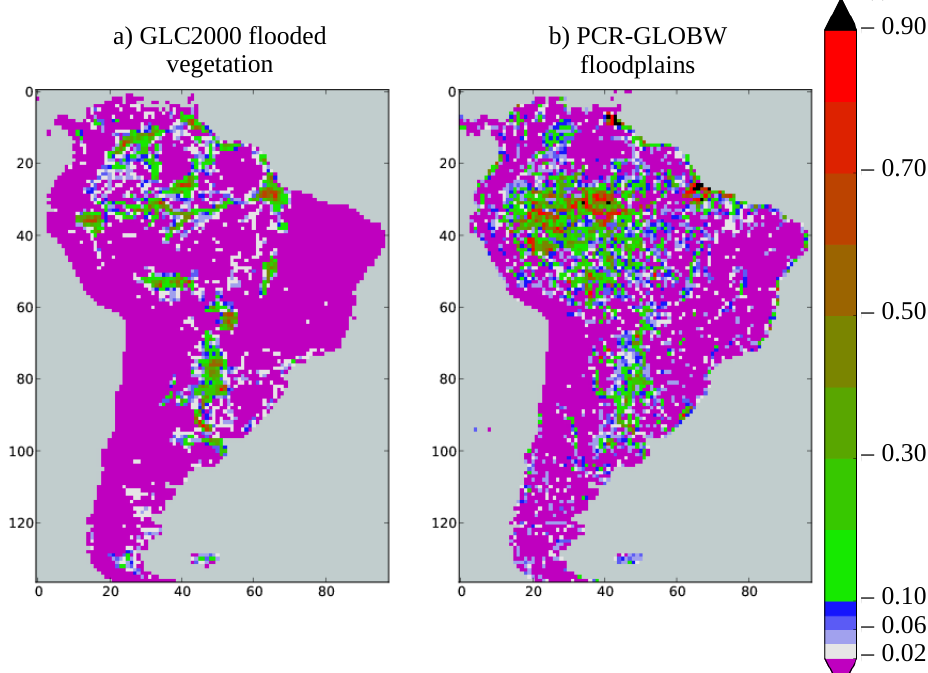
Fig. 1. Fraction of total grid cell at 0.5 ◦ resolution (unitless) covered by (a) flooded vegetation as defined by GLC2000 and (b) floodplain given by PCR-GLOBWB (mean annual value over 1979–2009 of fldf mean ). The (b) panel map is used as input of LPX for simulations without year-to-year variability of floodplain extent (simulations 1–6 in Table 5).